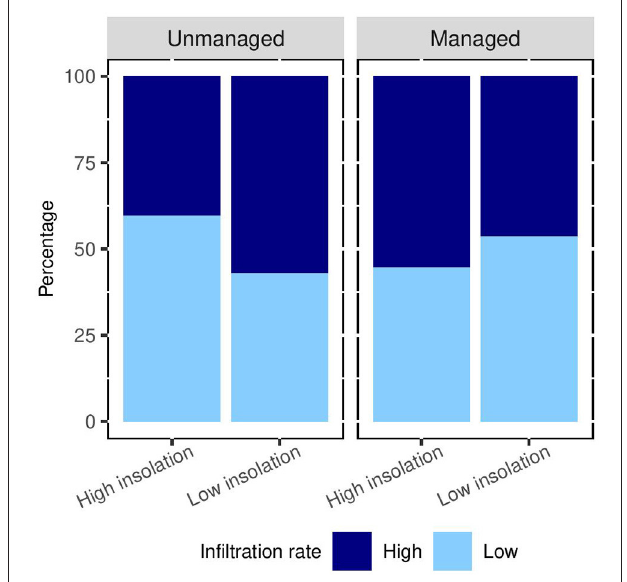
FIGURE 4 | Percentage of samples falling in the low (light blue, < 1.75 mL/min) or high (dark blue, ≥ 1.75 mL/min ) infiltration rate categories on the low insolation (north) or high insolation (south) side of the sampled